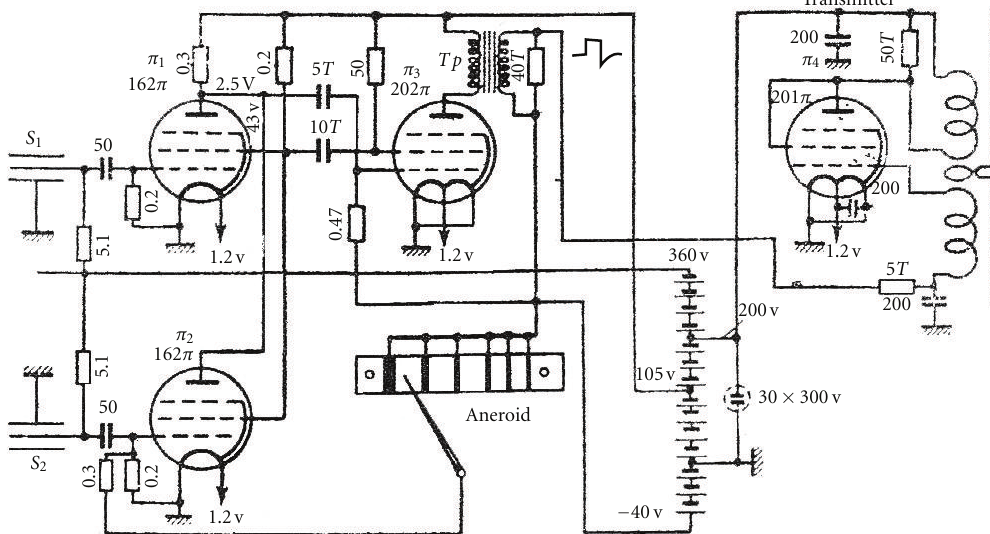
Figure 9: Electronic block diagram of the experiment measuring cosmic rays on a radiosonde.